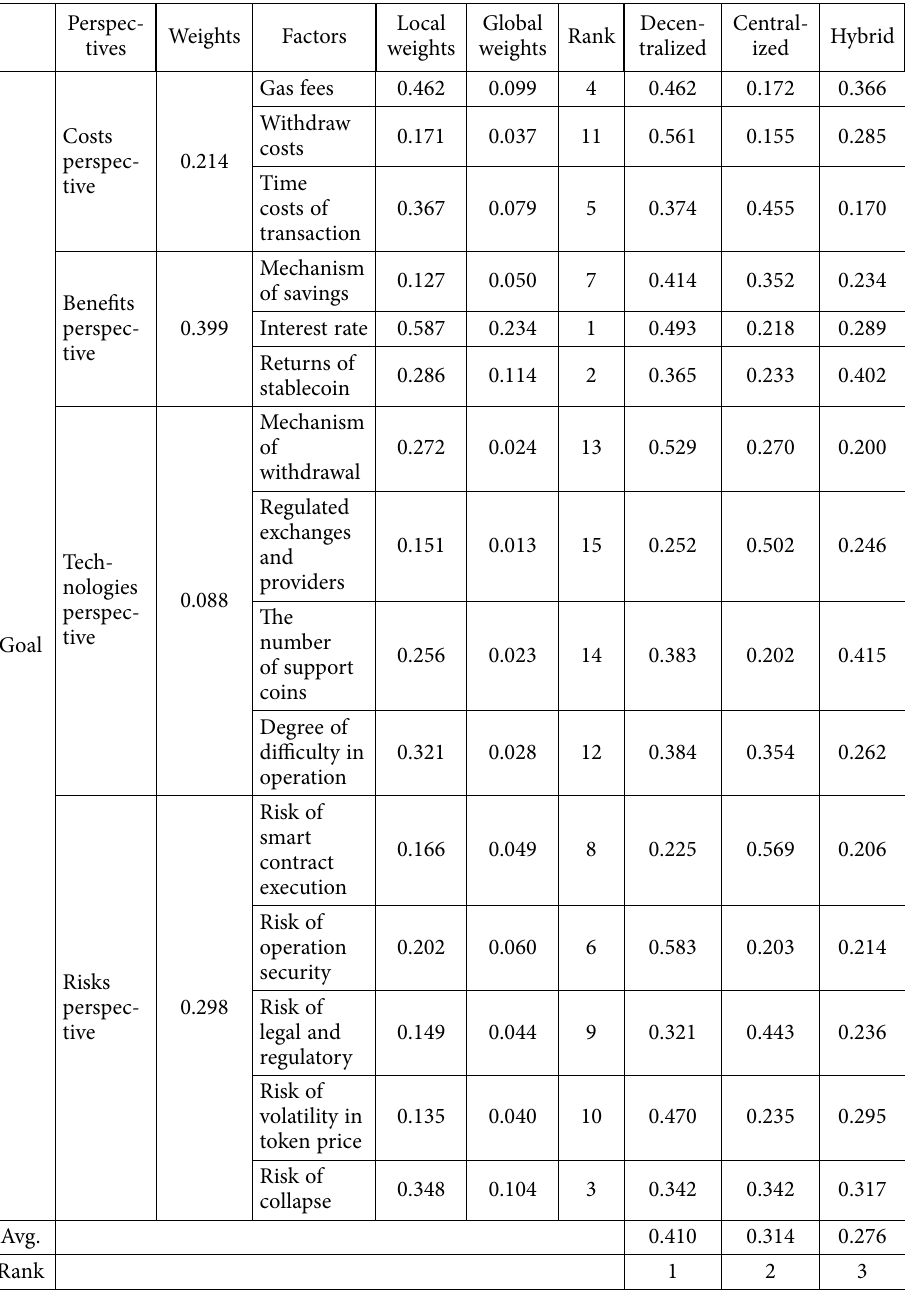
Decen- Central- Local Global Hybrid Rank tralized ized weights weights